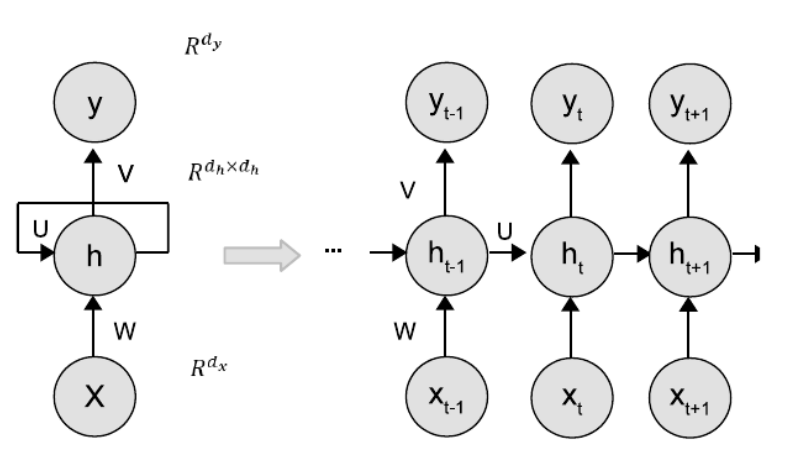
Figure 1. Recurrent neural network